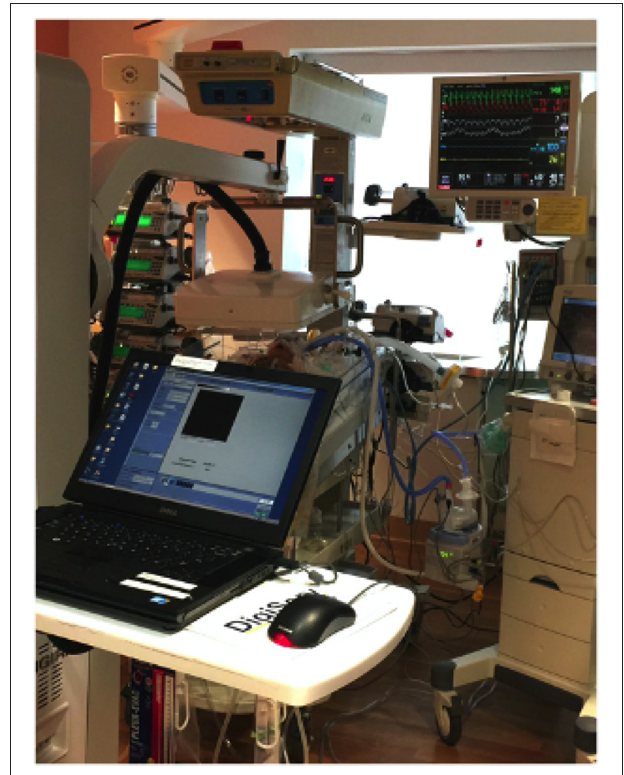
FIGURE 1 | Bedside mucociliary clearance scan for a neonate after congenital cardiac surgery. The Digirad Ergo portable gamma camera is positioned over the patient’s chest without touching the patient or interfering with any support